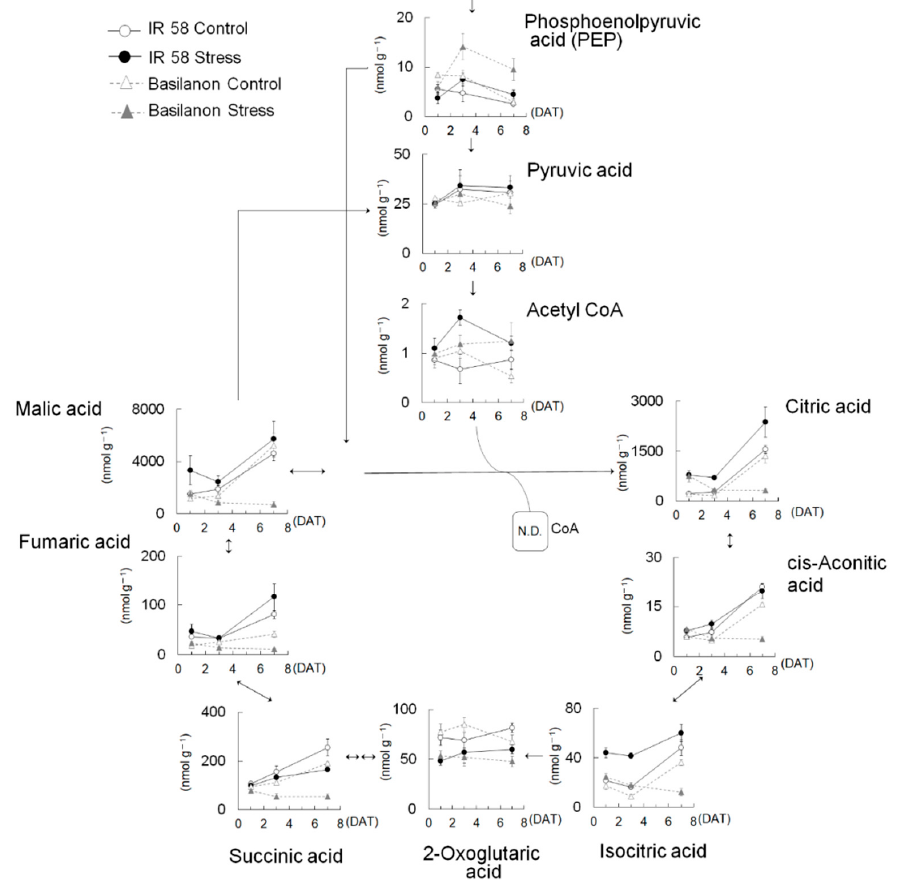
Figure 4. Changes in the number of metabolites in the pathways of glycolysis and citric acid cycle in the roots. Roots were sampled at 1, 3, and 7 days (24, 72, 168 h) after treatment (DAT). Bars indicate the standard error ( n = 3).